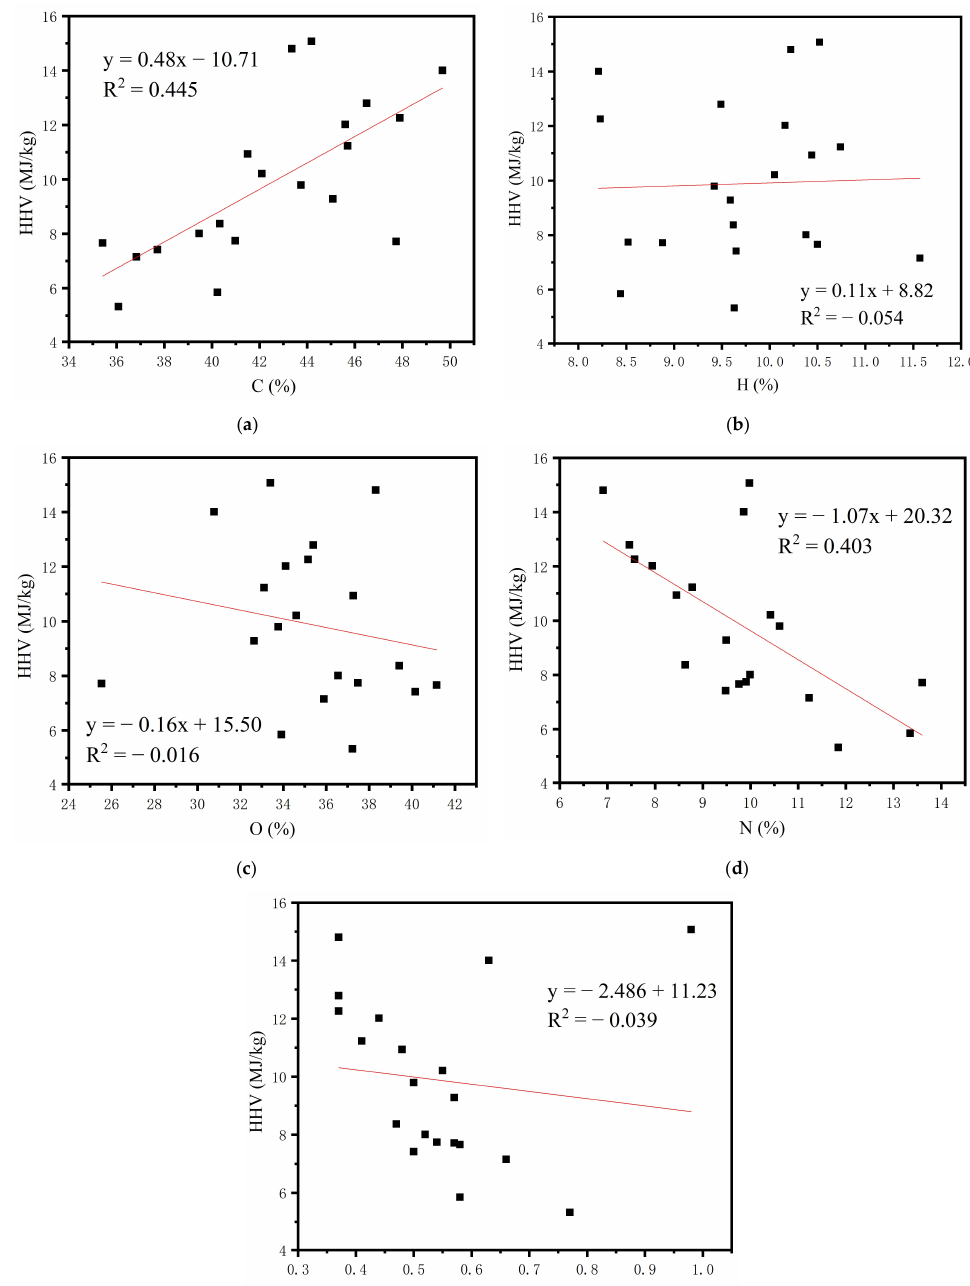
Figure 3. Correlation between HHV and ultimate analysis data: ( a ) indicates the correlation between carbon and HHV; ( b ) indicates the correlation between hydrogen and HHV; ( c ) indicates the correla- tion between oxygen and HHV; ( d ) indicates the correlation between nitrogen and HHV; ( e ) indicates the correlation between sulfur and